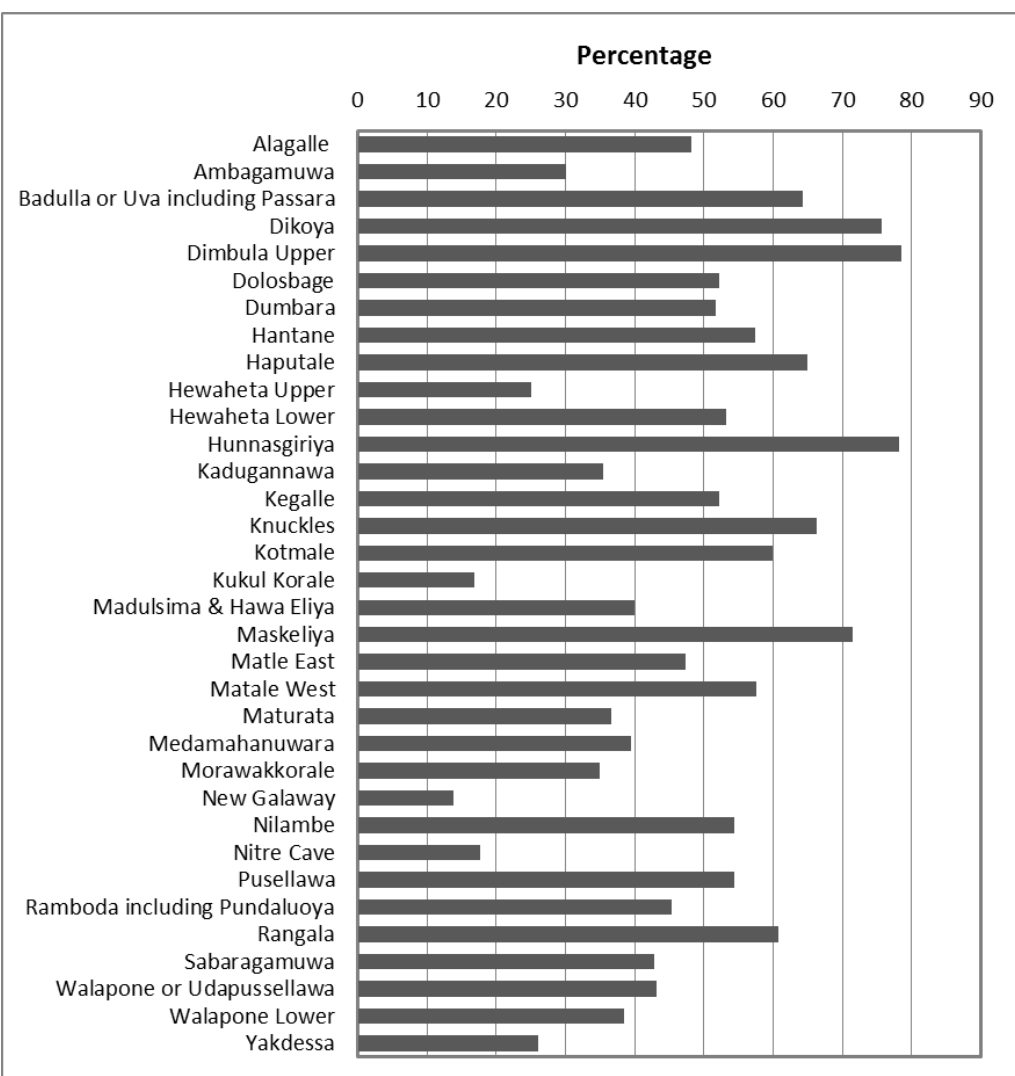
Figure 5: Cultivated area in 1875 as percentage of the total estate lands.